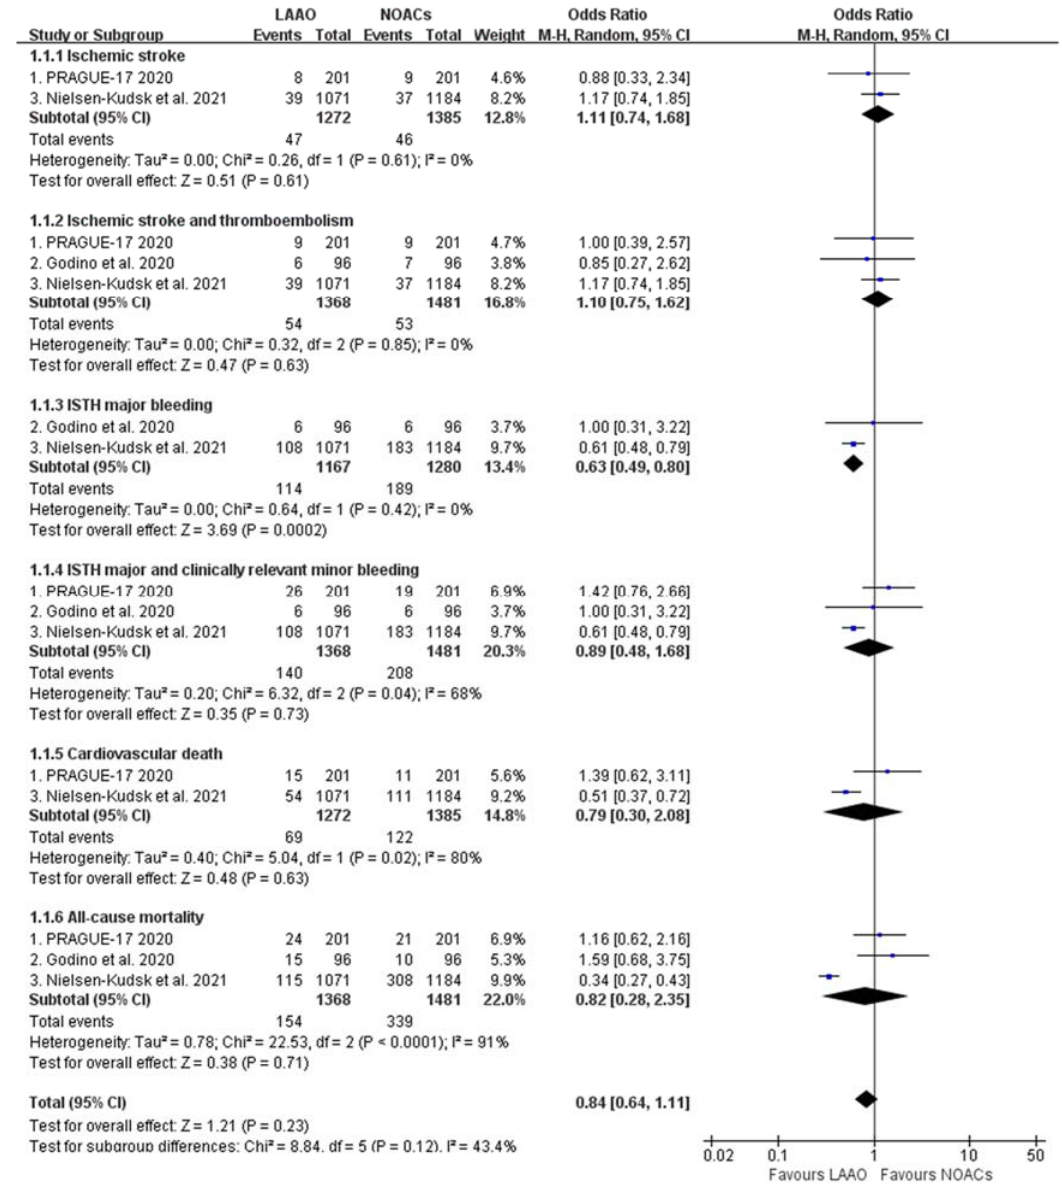
Figure 1. LAAO vs. NOACs: comparisons of major cardiovascular and neurological outcomes in high ‐ risk AF. LAAO procedure or device related serious complications are summarized in Table 3.